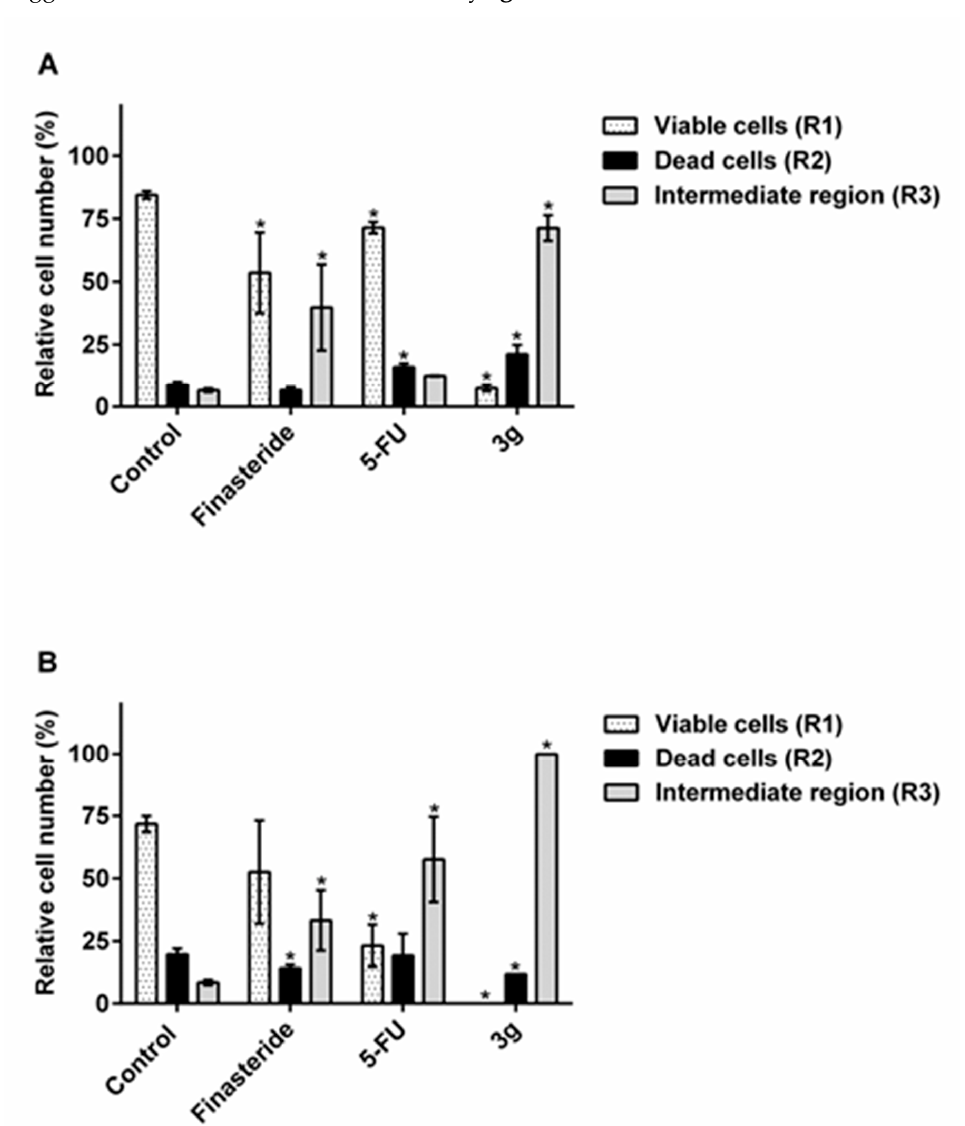
Figure 7. Distribution of the events in the regions R1, R2 and R3 (relative cell number): ( A ) after 24 and ( B ) 72 h of treatment with finasteride, 5-fluorouracil (5-FU) and 3g . Data are expressed as mean ± SD of the percentage of cells in the different regions (n = 4–6) and are representative of at least two independent experiments. * p < 0.05 vs. the control (ANOVA).